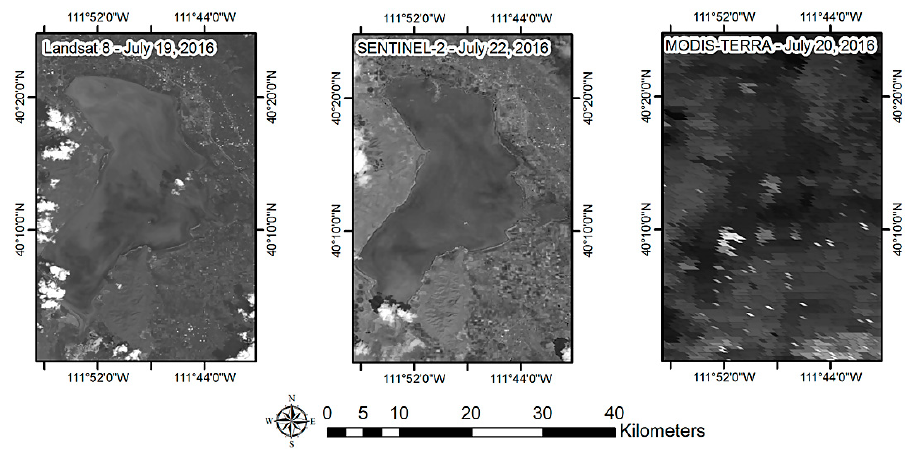
Figure 5. Comparison of Spatial Resolution in Coverage of Utah Lake at 30 m (Landsat 8, Band 2), 60 m (SENTINEL-2, Band 1) and 500 m (MODIS, Band 3).